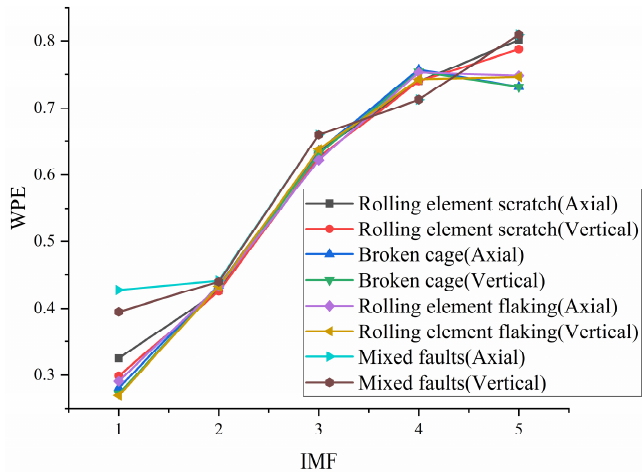
Figure 12. WPE of IMF of various signal.